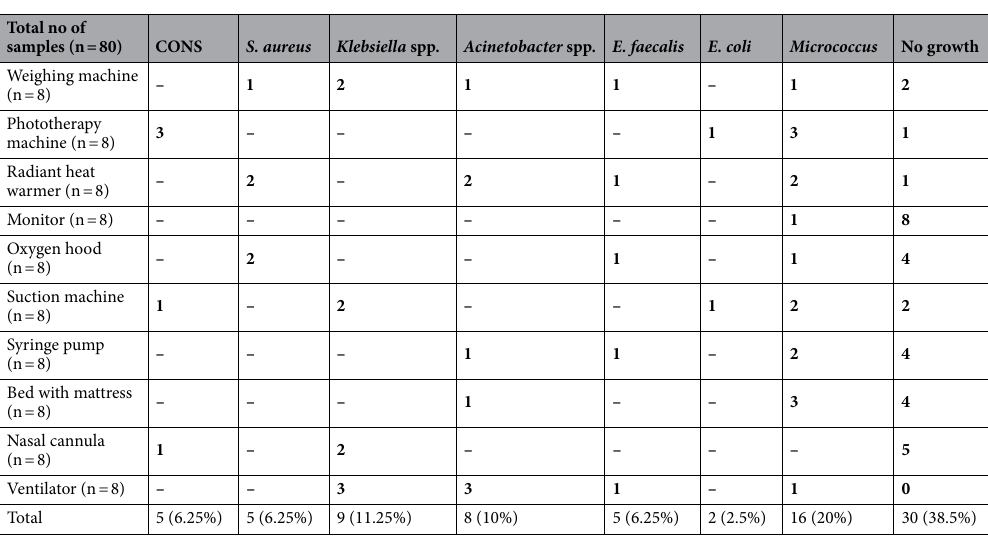
Table 4. Organism isolated from various site of medical instruments in NICU. Different organisms isolated from instruments of NICU, the organisms which were isolated are CONS (5), S. aureus (5), Klebsiella spp. (9),